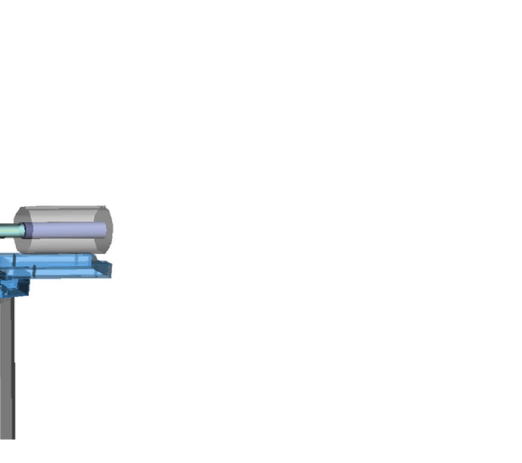
Figure 1. Illustration of the orientation of the x, y, and z axes of measurement with respect to the WT drivetrain. Table 1. Available variables and their respective attributes.